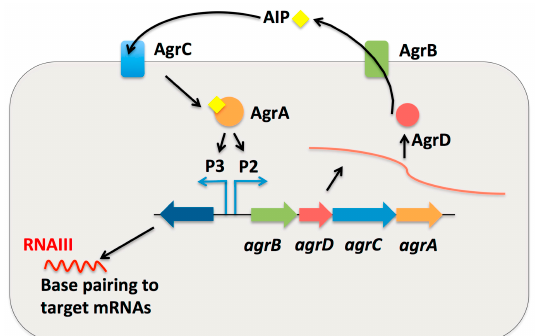
Figure 5. An sRNA is used as an effector molecule in quorum sensing systems. Quorum sensing is a means of cell-cell communication in bacteria to exchange information about cell density and thereby adjust gene expression in the cell. In the S. aureus Agr quorum sensing system, the autoinducing peptide (AIP) is synthesized from the AgrD peptide. Following the modification of AgrD, the mature AIP is transported out of the cell through the AIP transporter membrane protein, AgrB. This AIP is then recognized by the two-component system AgrC and AgrA. AgrC is the membrane-bound histidine kinase that is activated by the binding of AIP. AgrA is the response regulator that becomes phosphorylated and this phosphorylated AgrA activates either the P2 or P3 promoter. Activation of P2 regulates the expression of the agr operon, also referred to as RNAII, which controls the quorum sensing process. Activation of P3 regulates the expression of the sRNA RNAIII. RNAIII goes on to then regulate the expression of target mRNAs.